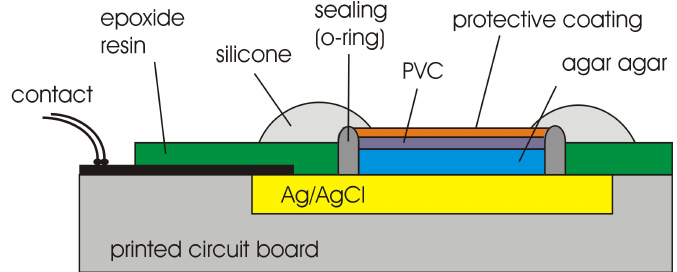
Figure 1. Cross section of the miniaturised reference electrodes with KCl-containing membrane and protective